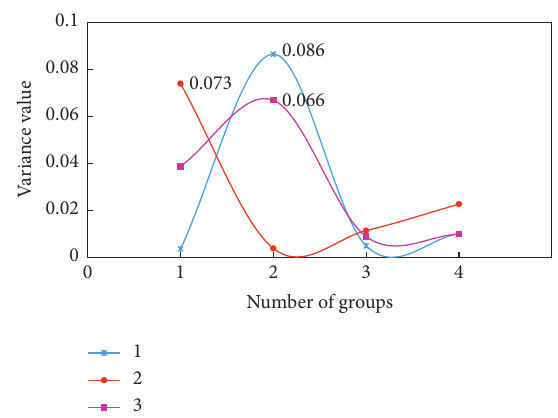
Figure 12: Two-dimensional entropy maximum variance analysis of samples from the same